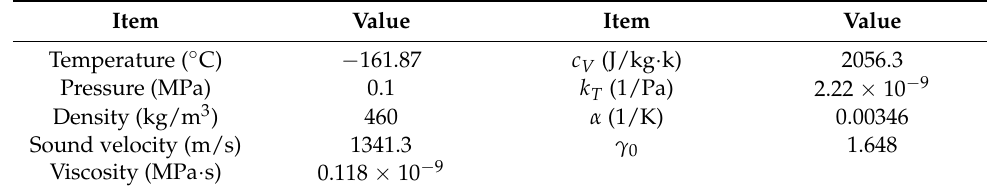
Table 3. Material properties of